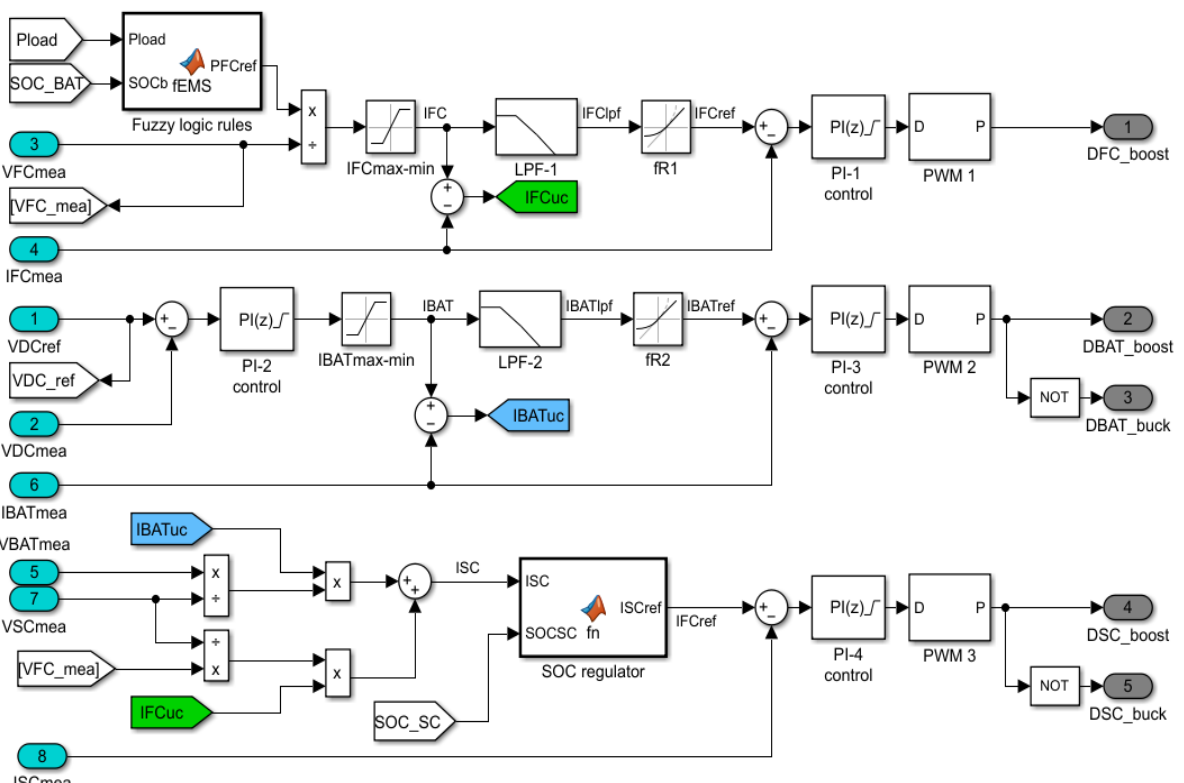
20 of 26 Table 9. SC bank parameters. Parameter 25 o C Table 10. BAT parameters. 6 Table 11. Proposed control strategy parameters. Parameter